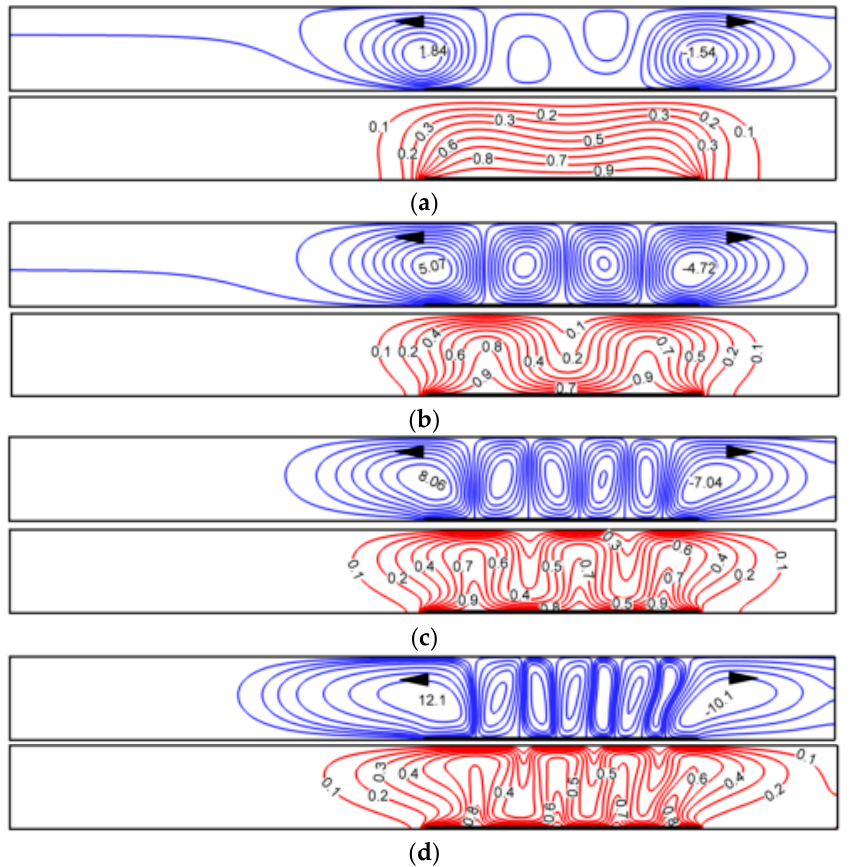
Figure 5. Streamlines (above) and isotherms (below) profiles for different Ra numbers and Pe = 1, ( c = 0.66), ( a ) Ra = 100, ( b ) Ra = 250, ( c ) Ra = 500, ( d ) Ra = 1000